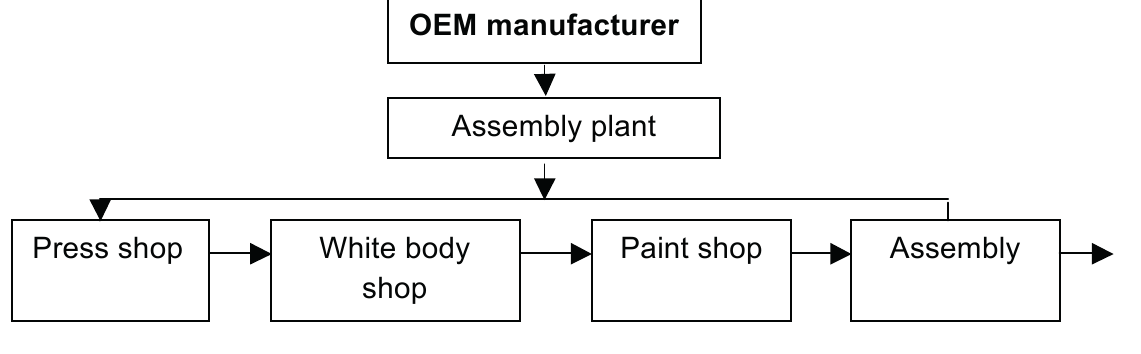
Figure 4: Activities in the production process of the model